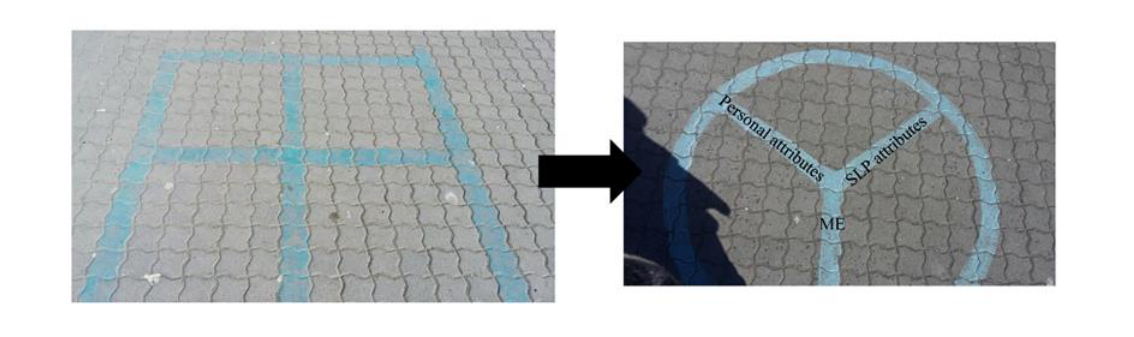
Figure 1. Aqueelah’s depiction of her experience of the emerging practice in speech - language pathology (SLP) taken during photovoice. Wording on photograph included by the researcher to supplement student